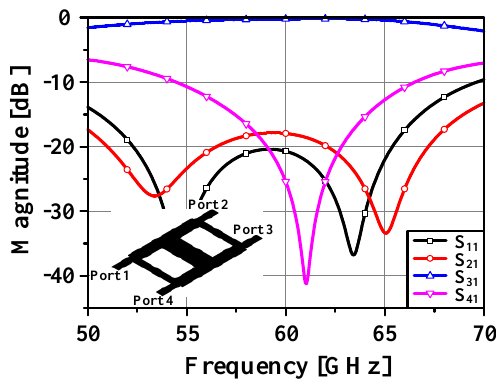
Figure 5. Simulated amplitudes of S-parameters of the crossover.